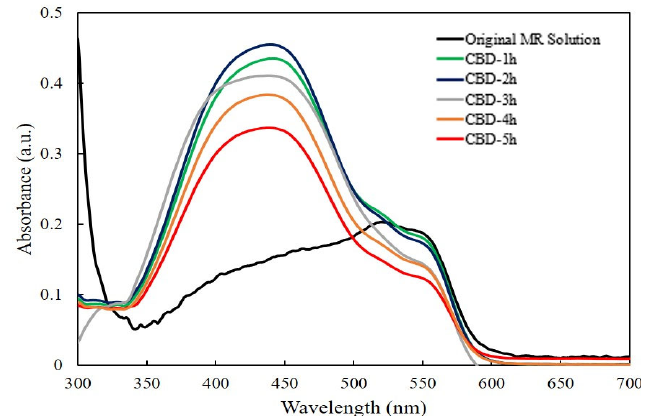
Figure 5. The absorption spectra of irradiated MR solution for ZnO nanorods with different reaction times without UV light.